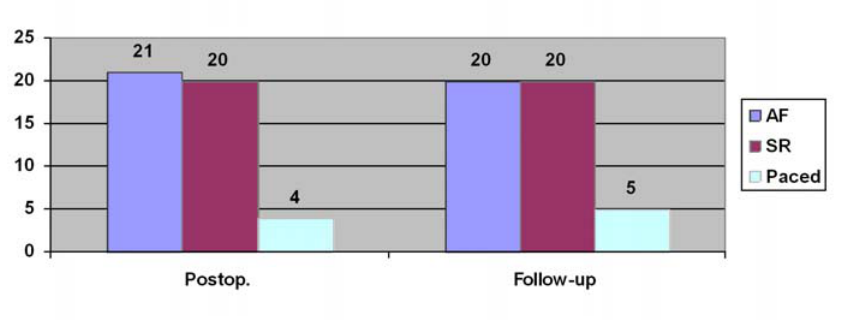
Fig. 2 Type of heart rhythm after procedure and in long term